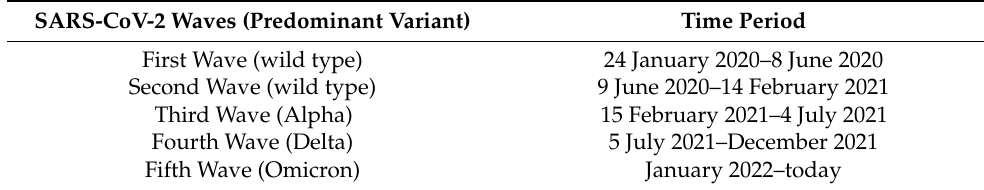
Table 1. Definition of SARS-CoV-2 waves in Germany by the Robert Koch Institute (RKI) [19]. SARS-CoV-2 Waves (Predominant